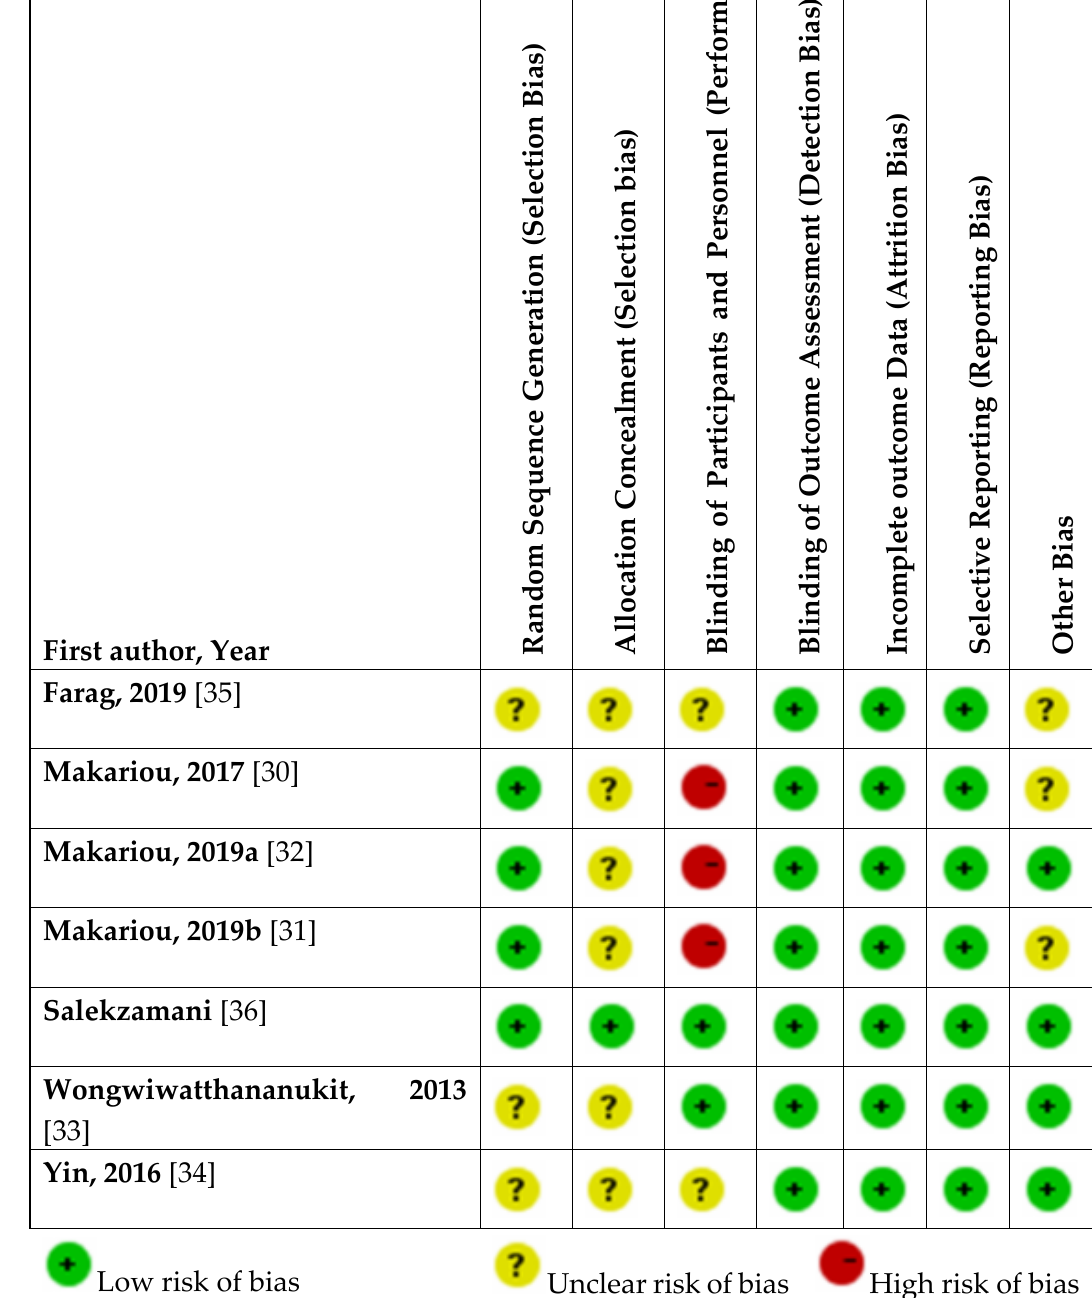
Figure 2. Risk of bias of included studies from consensus between a pair of raters.